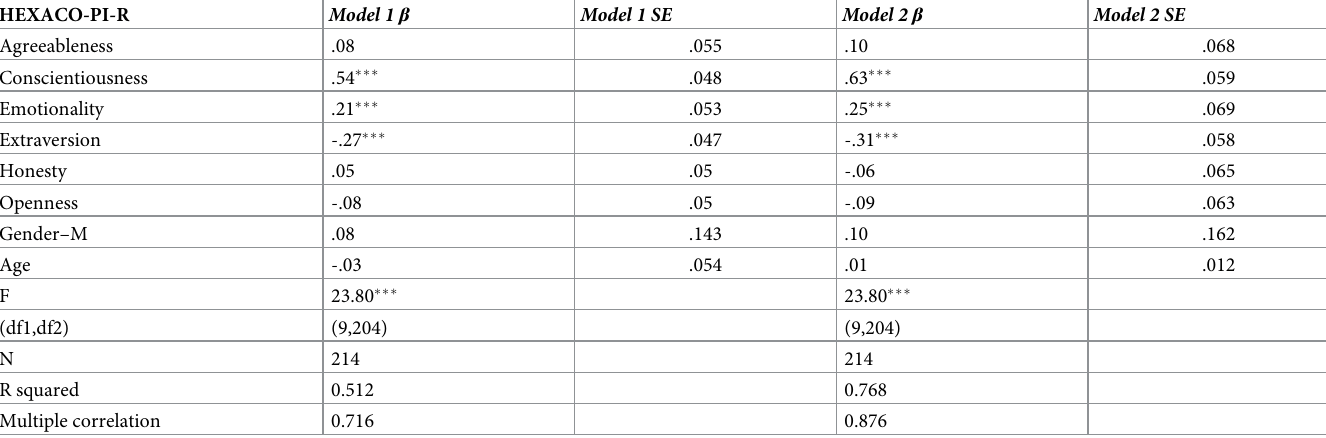
Table 4. Regression analyses for the two models with the